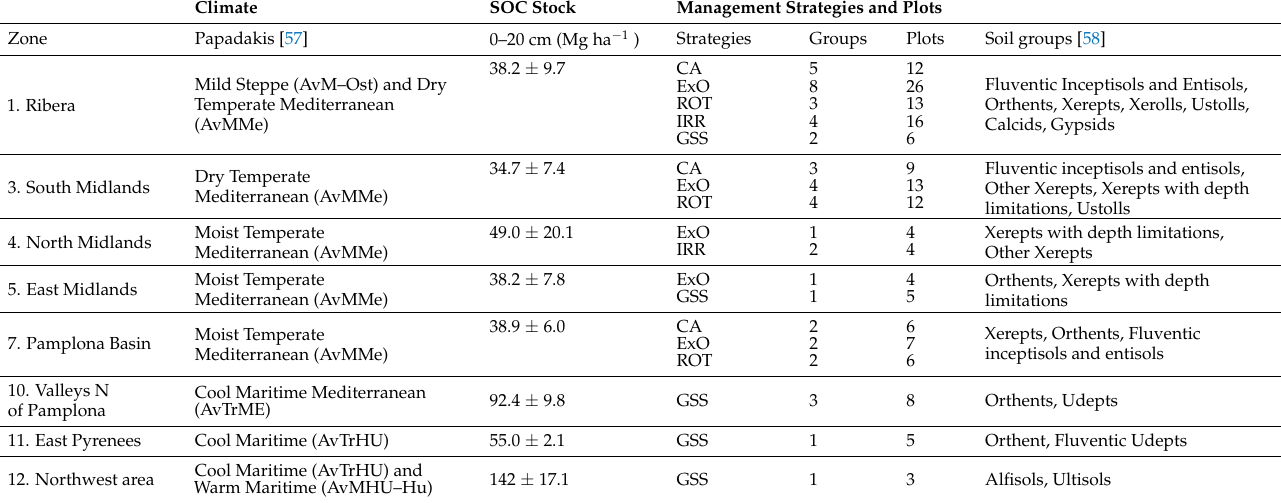
Table 1. Climate [57], average SOC stock in conventionally-managed plots at 0–20 cm (Mean ± standard deviation), management strategies, number of groups and plots, and soil groups [58]. Managements are conservation agriculture (CA), addition of exogenous sources of organic C (ExO), rotations (ROT), irrigation (IRR), and controlled grazing and/or rotation in grasslands